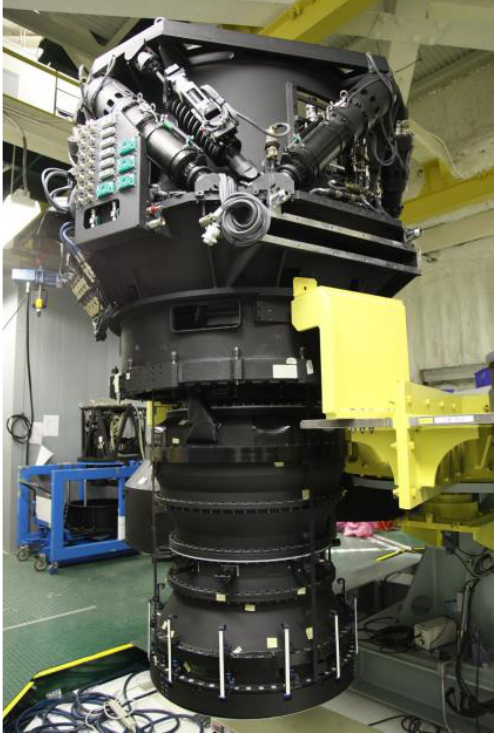
Figure 3. Hyper Suprime-Cam of Subaru Telescope [24].